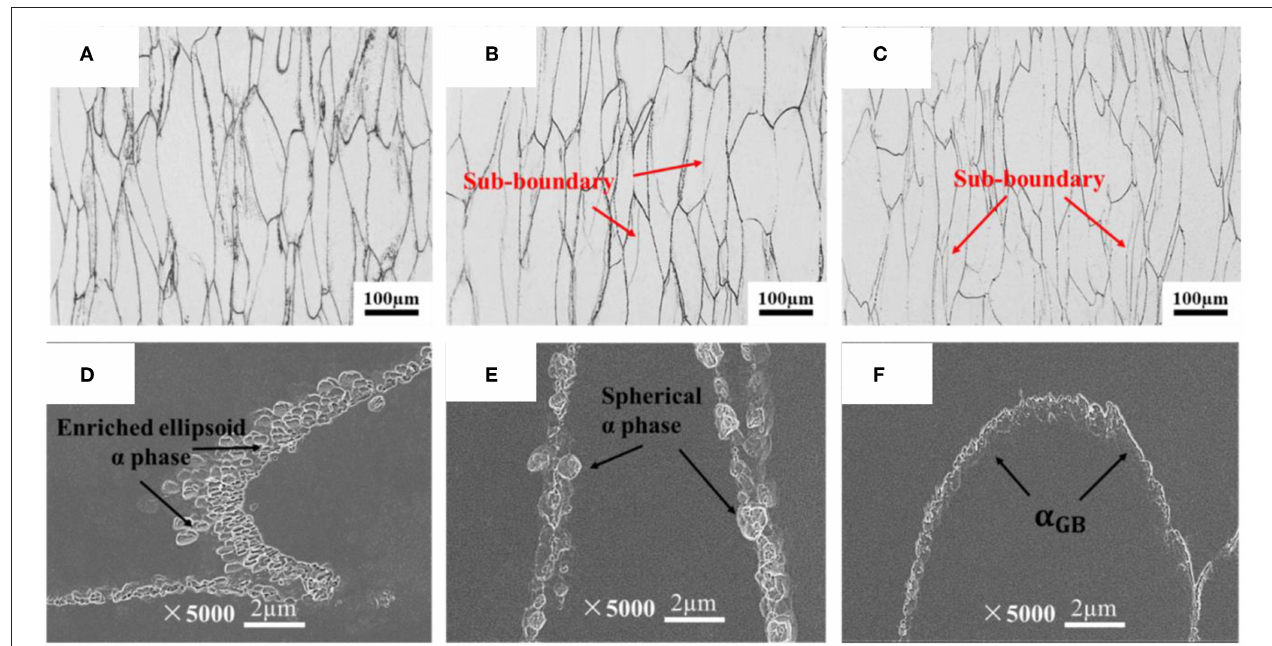
FIGURE 6 | Metallography after isothermal compression under 655 ◦ C with different strain rate of (A) 10 − 3 s − 1 (B) 10 − 2 s − 1 , (C) 10 − 1 s − 1 , and SEM images of the grain boundary at 655 ◦ C with different strain rate of (D) 10 − 3 s − 1 (E) 10 − 2 s − 1 , (F) 10 − 1 s − 1 .